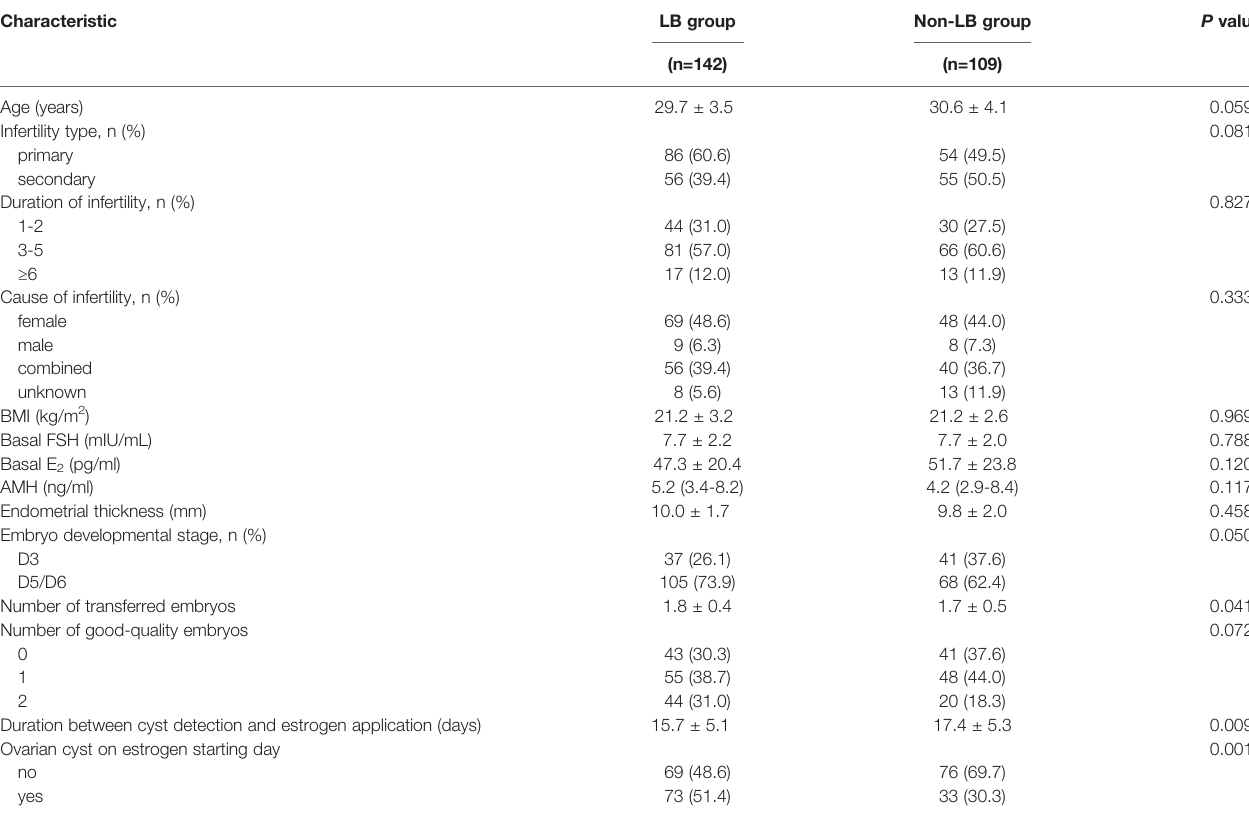
TABLE 7 | Characteristics between cycles reaching live births or failing to have live births under the conservative approach.